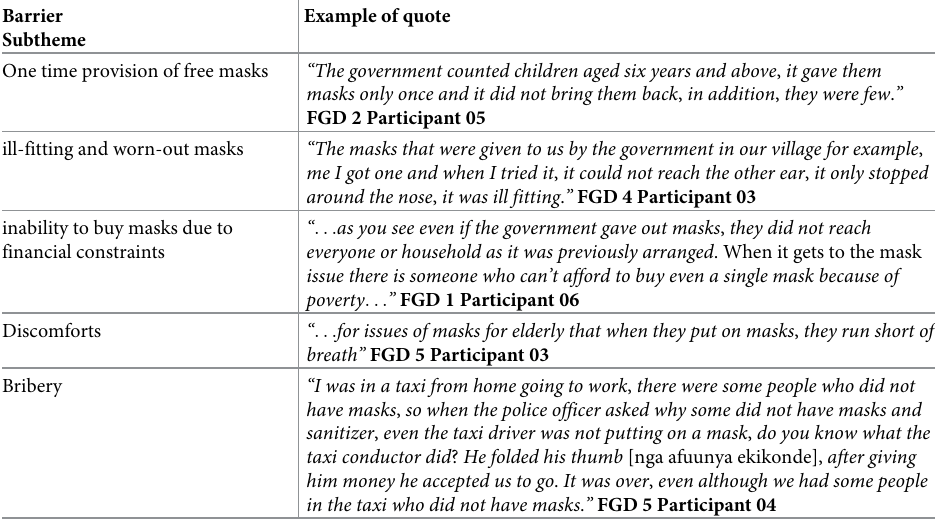
Table 4. Qualitative findings pertaining to barriers of mask